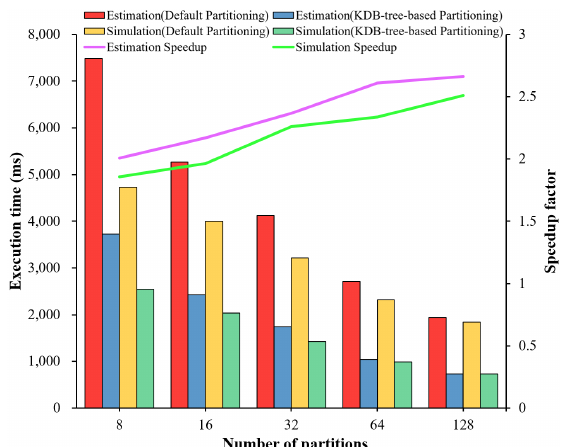
Figure 9. Performance comparison of cross K function with and without partitioning under increasing number of partitions